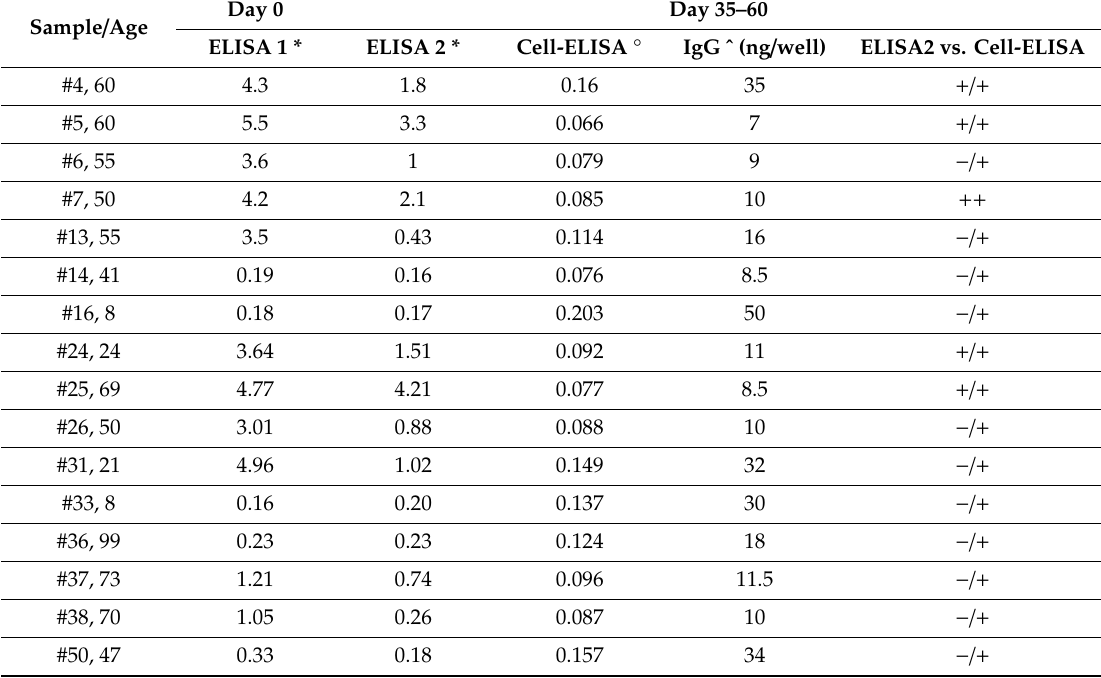
Table 2. ELISA / cell-ELISA comparison. The table shows data from 16 donors who tested positive by cell-ELISA for IgG with their age, and the plasma ELISA OD450 values for IgG measured at day 1 (ELISA 1), and in the same donor after 35–60 days (ELISA 2). A comparison between ELISA 2 results and cell-ELISA is shown, where a ( +/+ ) indicates a positive result in both tests, and a ( − /+ ) indicates a negative result in ELISA 2 and a positive result in cell-ELISA. The cell-ELISA numbers are the net OD450 values ( ◦ ). The ELISA values are expressed as the ratio between OD450 of sample / cuto ff value (*), considered negatives for < 0.9, equivocal between 0.9–1.1, and considered positives for > 1.1. A relative IgG concentration in cell-ELISA is indicated ˆ, as deduced from a reference γ -globulin